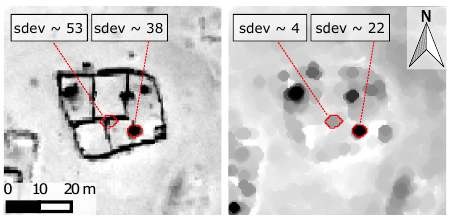
Figure A1. Subset of the pre-conflict layer before (left image) and after (right image) morphological closing. It shows the effect of the filter on a dwelling object (right object) and a fence (left object). The higher impact of the filter on small, linear structures is used as an additional feature to remove them by measuring the ratio of the standard deviation per object of the unfiltered to that of the filtered layer.